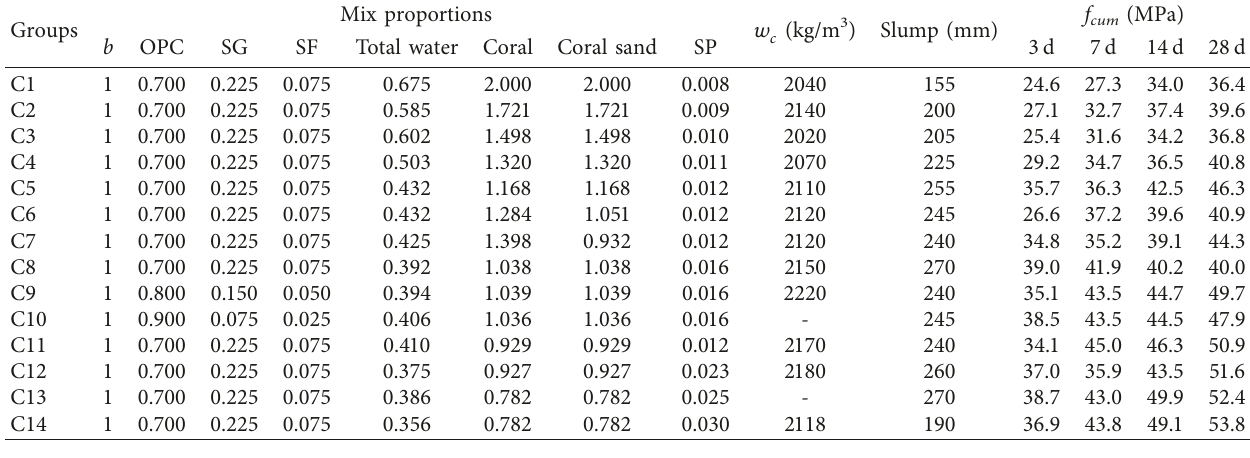
Table 4: Coral concrete mix proportions.